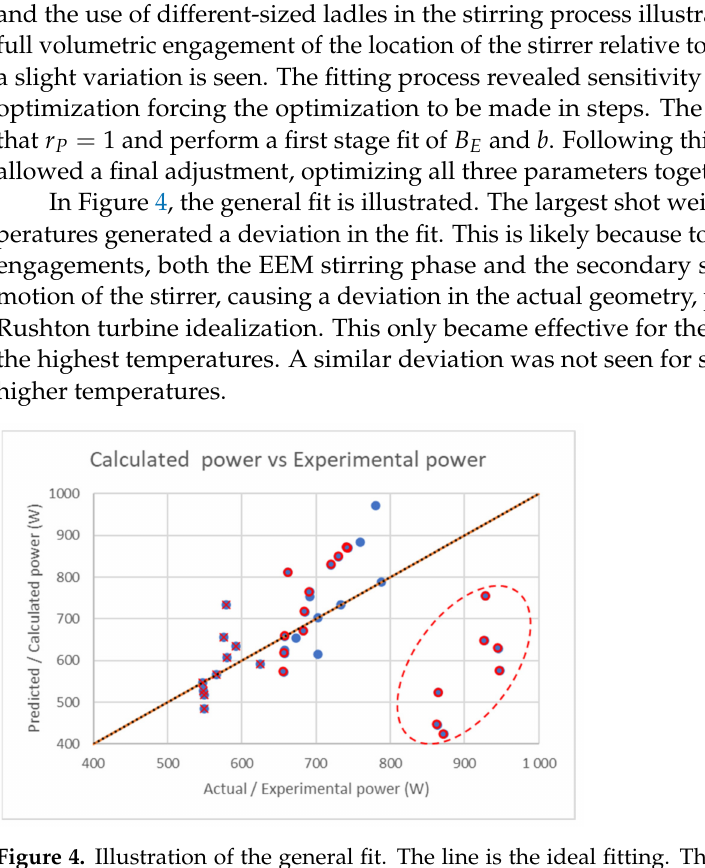
Figure 4. Illustration of the general fit. The line is the ideal fitting. The markers with a red circle are results from the 20 kg shot weight, and those indicated with a red cross are the 2 kg shot weight experiments. The points within the dashed circle are the deviating points arising from the largest shot weight of 20 kg, with melt temperatures above 768 ◦ C.